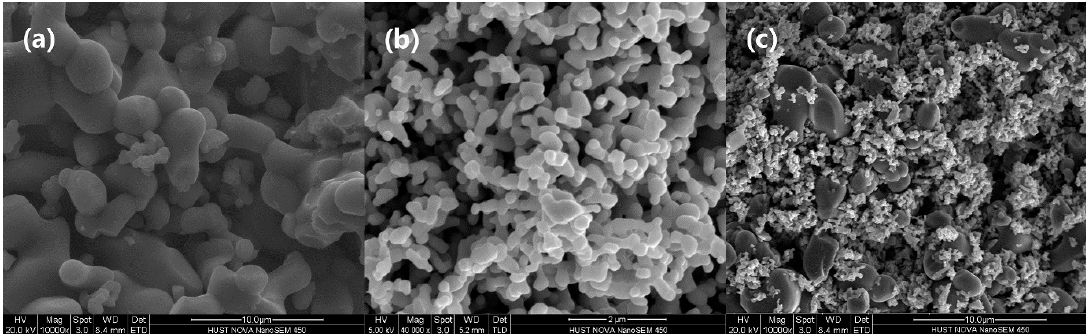
Figure 4. SEM micrograph of CCTO powder with different particle sizes: ( a ) micron, ( b ) submicron, and ( c ) micron/submicron co-blending.